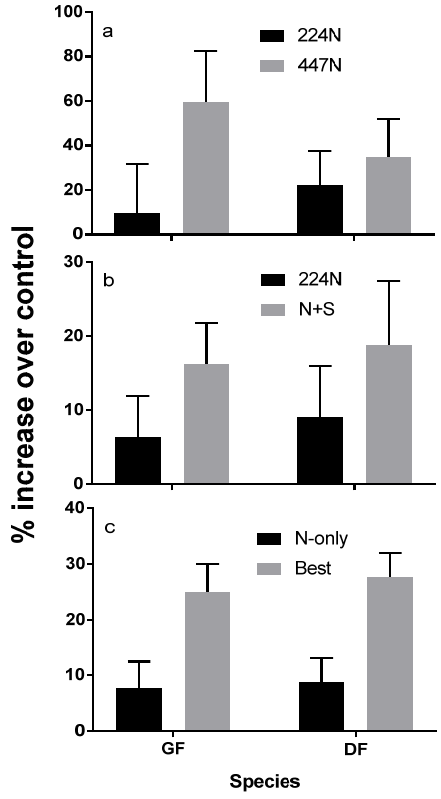
Figure 7. Grand fir (GF) and Douglas-fir (DF) volume increment response in three different fertilization trials at various locations. ( a ) Average annual ten-year response to two levels of N-only fertilization at 224 and 447 kg N ha − 1 in 30 Douglas-fir dominated (80% basal area) stands in Idaho, Montana, Oregon and Washington including five parent material classes and three vegetation series representing the range of regional productivity [30]; ( b ) Average annual eight-year response to either 224 kg N ha − 1 or 224 kg N ha − 1 + 73 kg S ha − 1 ) in seven mixed conifer stands growing on basalt parent materials at 1370 to 1680 m in Abies grandis and Abies lasiocarpa vegetation series [31]; ( c ) Average annual two-year response to individual-tree treatments of 224 kg N ha − 1 (N-only) or a blend of 224 kg N ha − 1